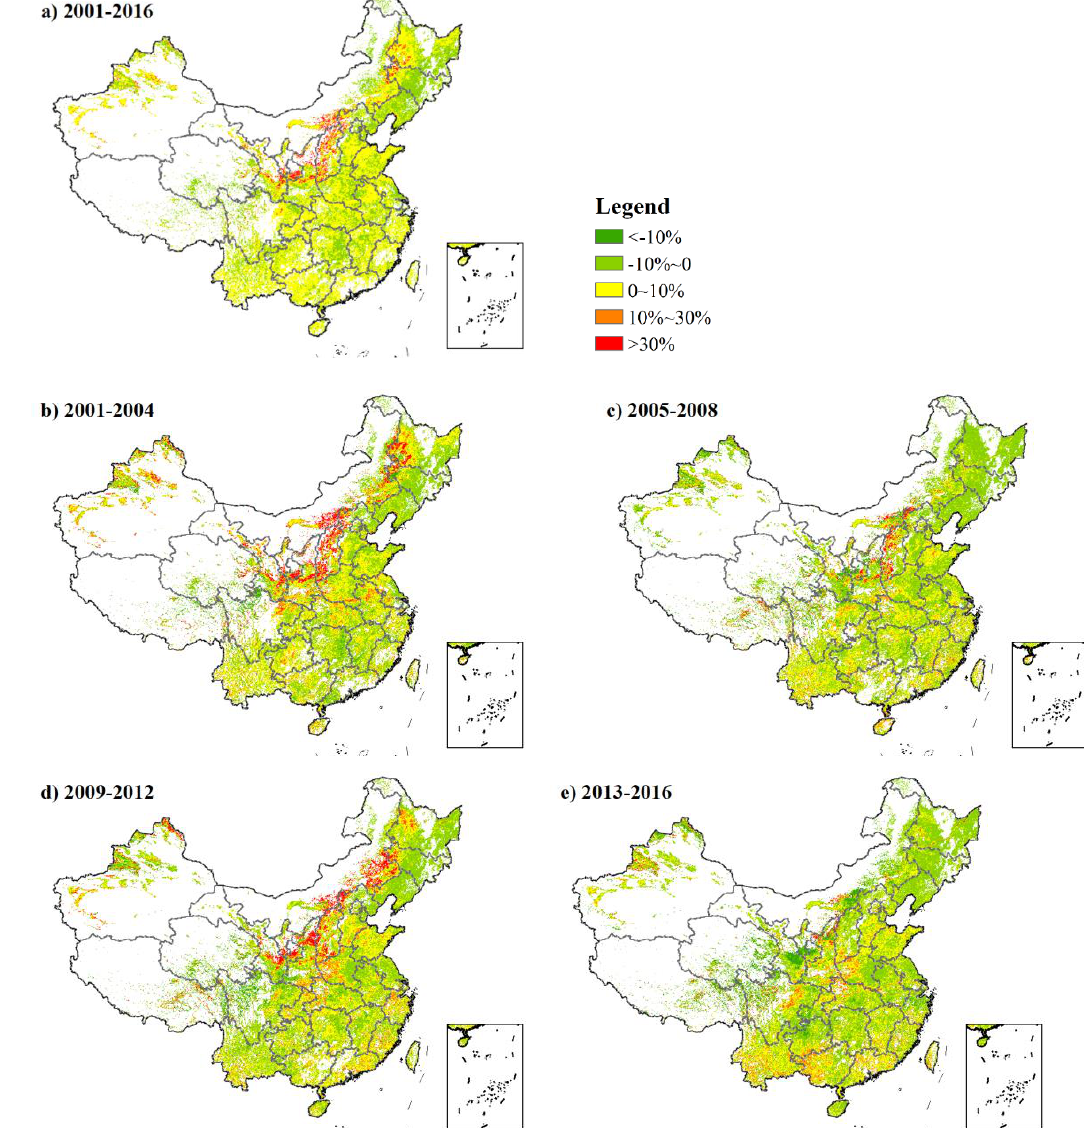
Figure 4. Changes in cropping intensity in China from 2001 to 2016 and at every four year interval. Changes in cropping intensity in China ( a ) from 2001 to 2016; ( b ) from 2001 to 2004; ( c ) from 2005 to 2008; ( d ) from 2009 to 2012; ( e ) from 2013 to